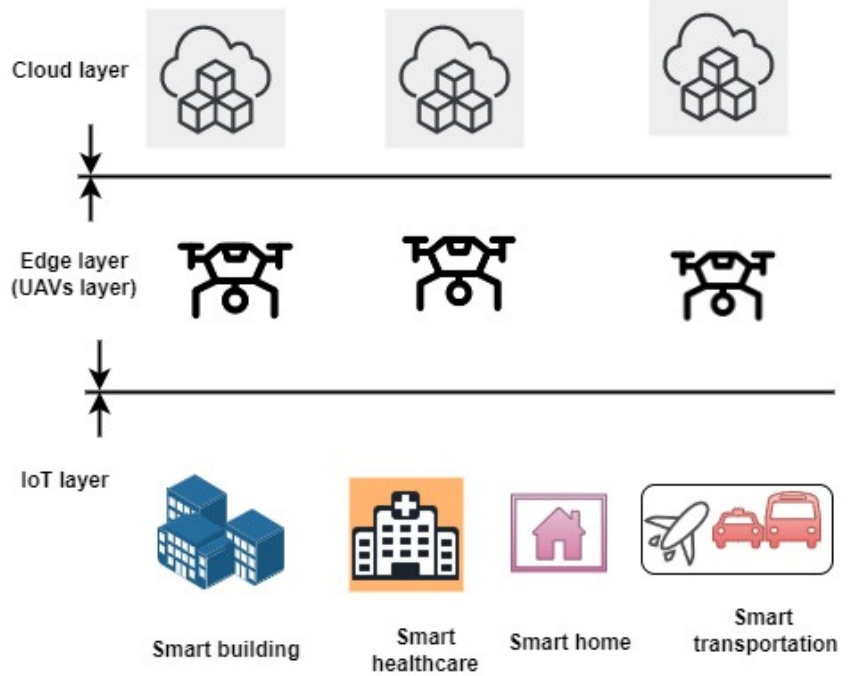
Figure 1. The network structure for IoT-enabled smart city .